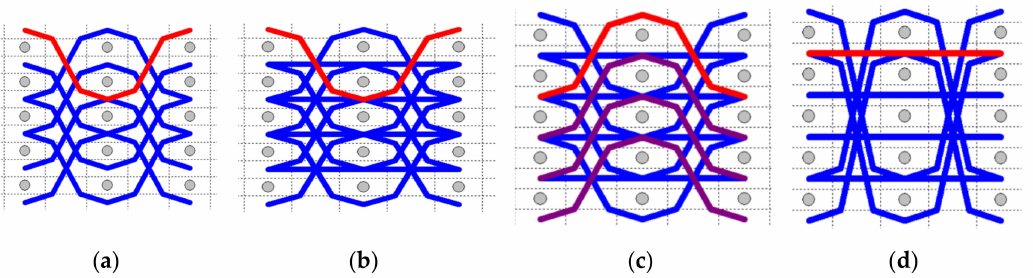
Figure 2. The graphical schemes of the developed 3D warp interlock fabrics with di ff erent binding and stu ff er ratios ( a ) 3D-8W-0S (100–0%), ( b ) 3D-8W-4S (66–33%), ( c ) 3D-8W-8S (50–50%), and ( d ) 3D-4W-8S